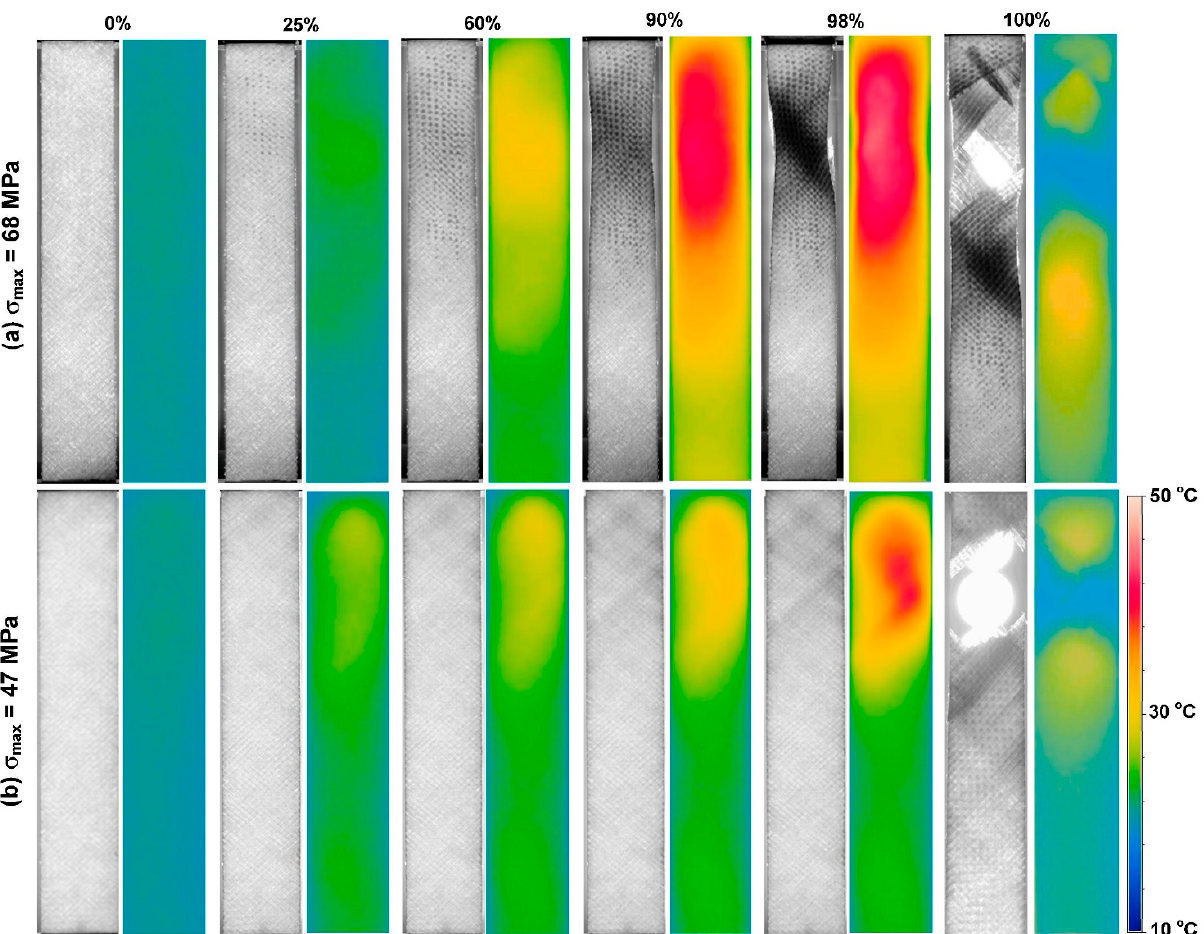
Figure 17. An experimental demonstration recorded using an infrared thermal camera for the self- heating effect at various percentages of fatigue life of ( θ = ± 45 ) with permission from Ref. [77]. Copyright © 2018 Elsevier